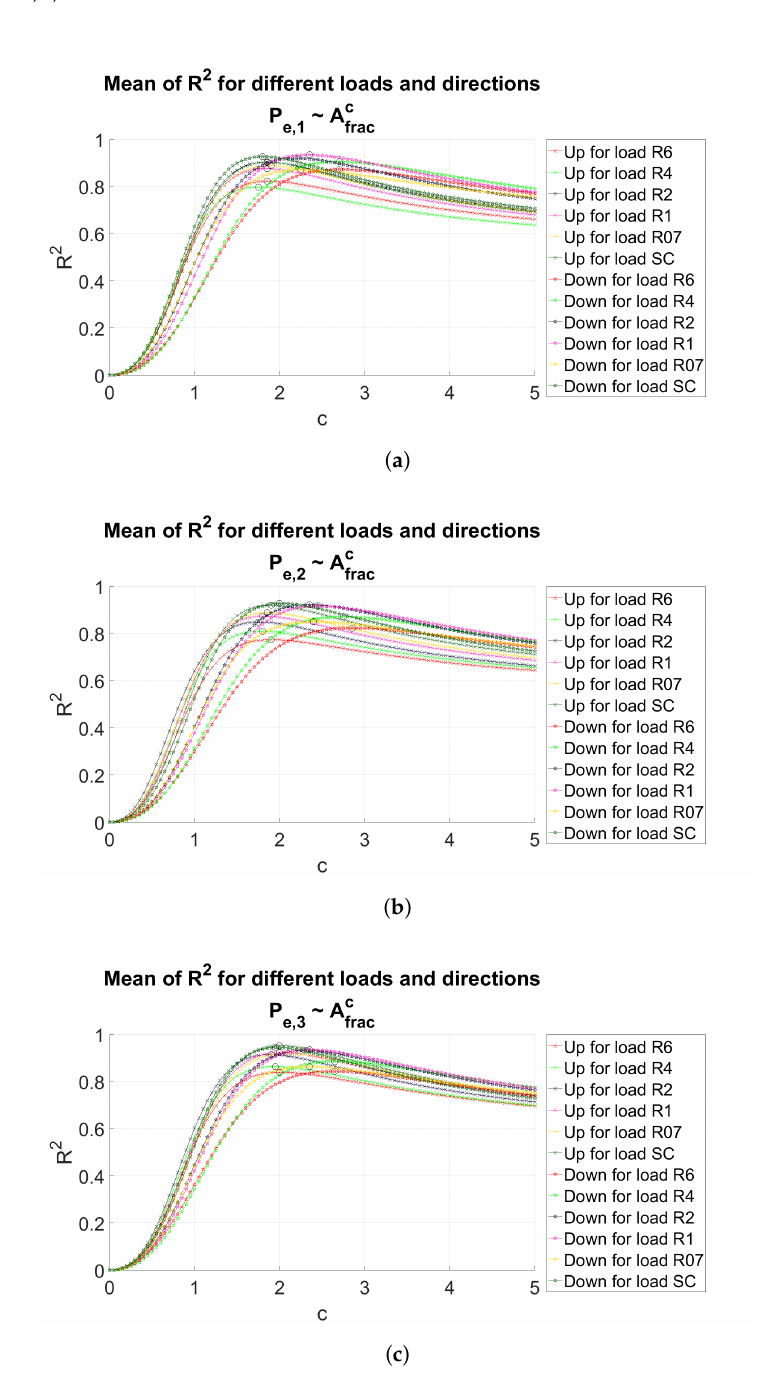
Figure 12. Mean of the coefficient of determination R 2 for different values of c for different loads and directions for the linear regression of P e , i ∼ A c for phase 1 ( a ), phase 2 ( b ) and phase 3 ( c ) ,when the frac intercept is set to zero. In the legends, NL stands for No Load; R6 stands for load 6.6 Ω ; R4 stands for load 4.4 Ω ; R2 stands for load 2.2 Ω ; R1 stands for load 1.1 Ω ; R07 stands for load 0.73 Ω ; SC stands for Short